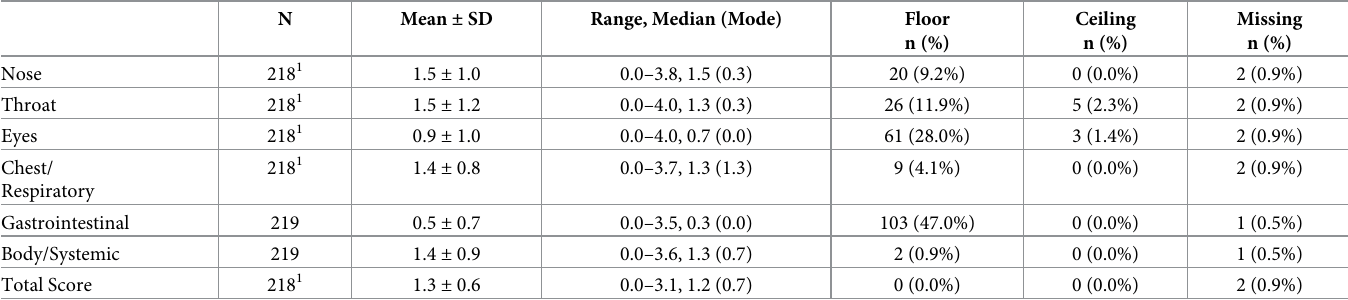
Table 2. FLU-PRO domain and total score descriptive statistics Day